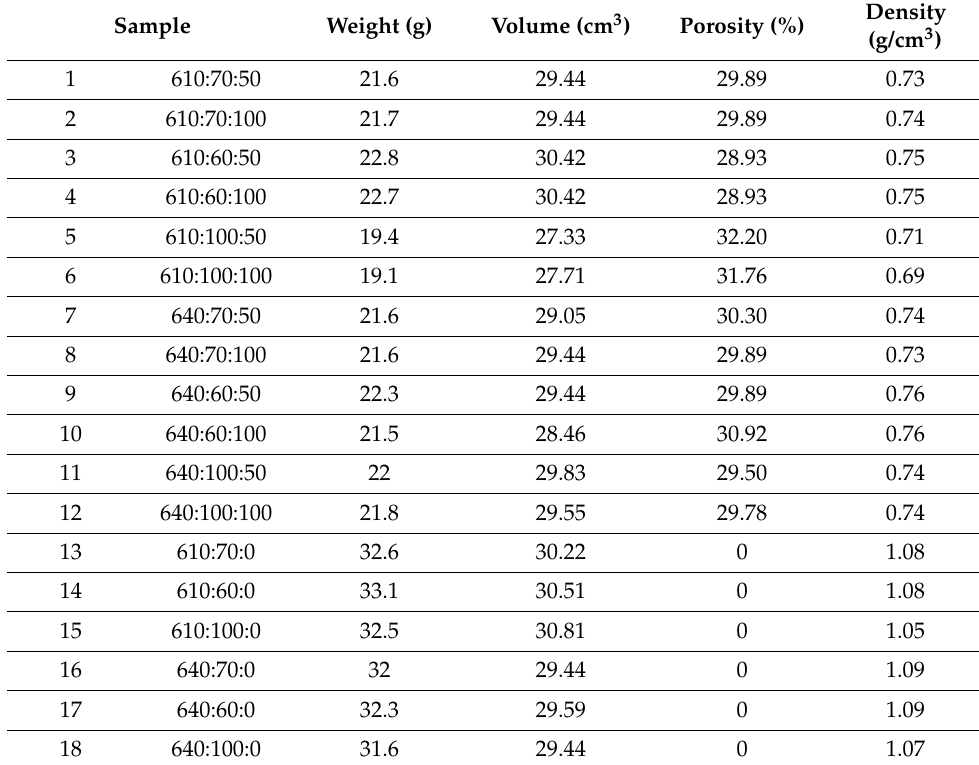
Table 2. Densities and porosities of the samples.